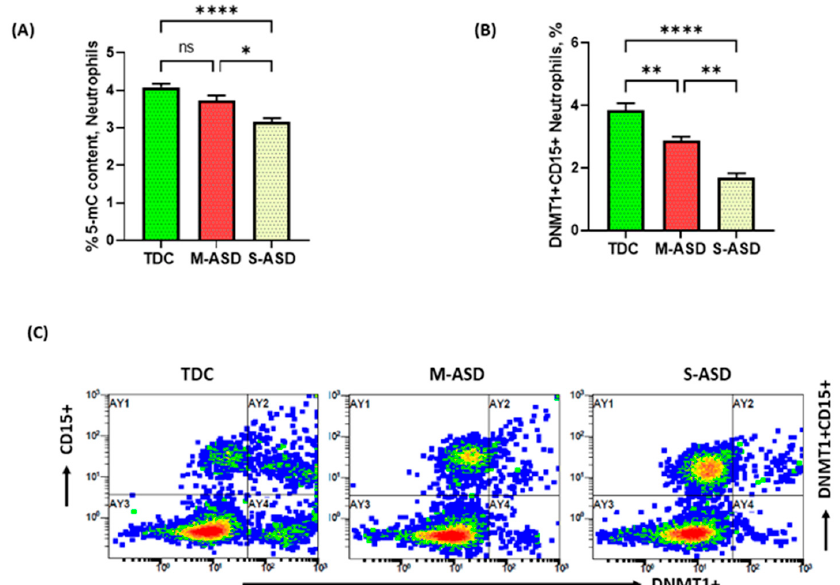
Figure 1. Methylation of DNA and DNMT1 expression in neutrophils of ASD and TDC subjects. ( A ) Global DNA methylation levels in neutrophils, ( B ) DNMT1 expression in neutrophils, and ( C ) illustrative flow diagram displaying DNMT1+CD15+ neutrophils. Values are presented as mean ± SEM, n = 24–28/group. * p < 0.05; ** p < 0.01; **** p < 0.0001; ns = not significant.